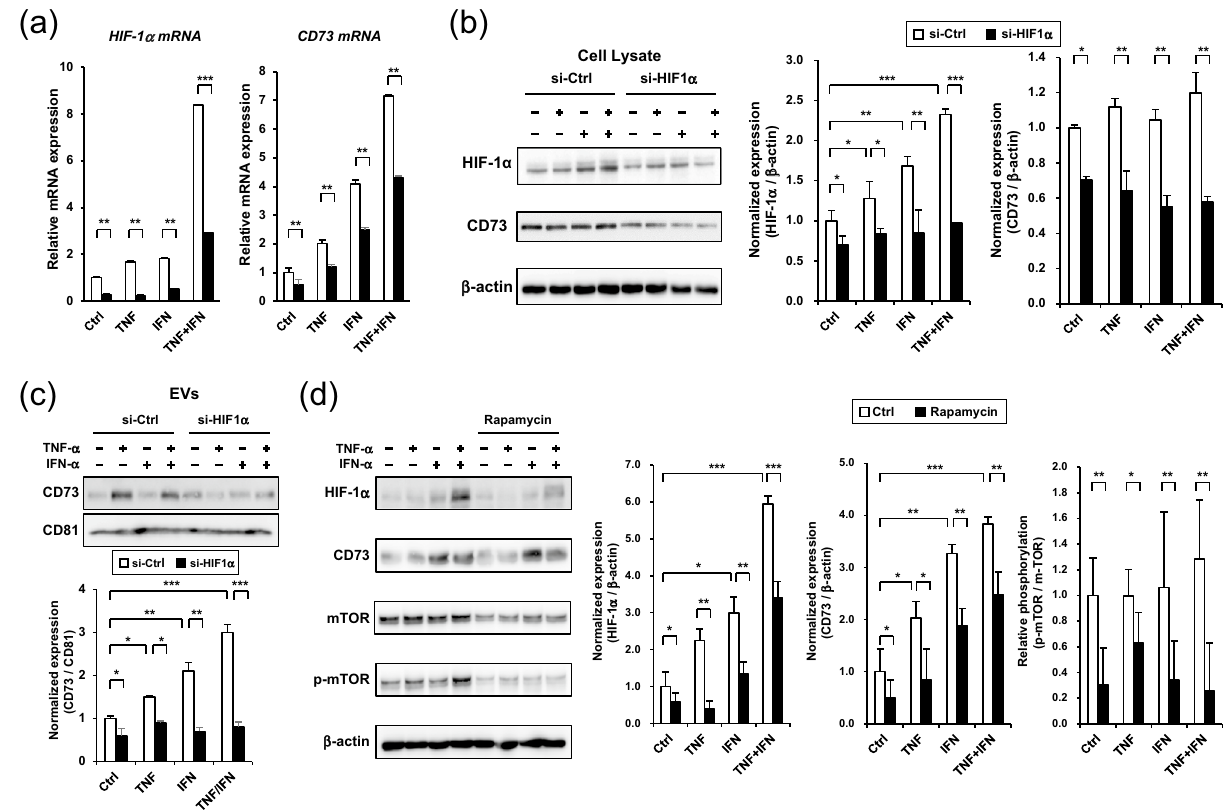
Figure 4. mTOR-HIF-α axis is critical for TNF-α/IFN-α-mediated induction of CD73 in GMSCs. GMSCs transfected with either control (si-Ctrl) or HIF-1α siRNA (si-HIF1α) were stimulated with TNF-α (100 ng/ mL), IFN-α (100 ng/mL), or TNF-α/IFN-α (50 ng/mL) for 24 h ( a ) and 48 h ( b – d ). ( a ) Total RNA was isolated and analyzed to evaluate HIF-1α and CD73 mRNA expression using quantitative real-time PCR. ( b ) Whole- cell lysates prepared from GMSCs were subjected to immunoblot analysis with anti-CD73 or anti-HIF-1α antibodies. β-actin was used as the control. Relative HIF-1α and CD73 protein expressions were measured by quantifying the density of bands and normalized against β-actin using the MultiGauge software (right). ( c ) Exosomal CD73 protein expression in equal amounts (5 μg) was compared by immunoblot analysis with an anti-CD73 antibody. Exosome-associated CD81 proteins were used as loading controls. Relative CD73 protein expressions were measured by quantifying the density of bands and normalized against CD81 using the MultiGauge software (lower). ( d ) Effect of rapamycin treatment on the expression of HIF-1α and CD73 in TNF-α, INF-α, and TNF-α/ INF-α-stimulated GMSCs. Inhibition of mammalian target of rapamycin (mTOR) activity was confirmed using a phosphorylated-mTOR antibody (p-mTOR, Se2448). Relative HIF-1α and CD73 protein expressions were measured by quantifying the density of bands and normalized against β-actin, and relative phosphorylation of mTOR were measured by quantifying the density of bands and normalized against mTOR using the MultiGauge software (right). * P < 0.05; ** P < 0.01; *** P < 0.001. Error bars represent mean ± SD, n = 3. The significance of differences between groups was determined using one-way Tukey’s test. Full blots are presented in Supplementary